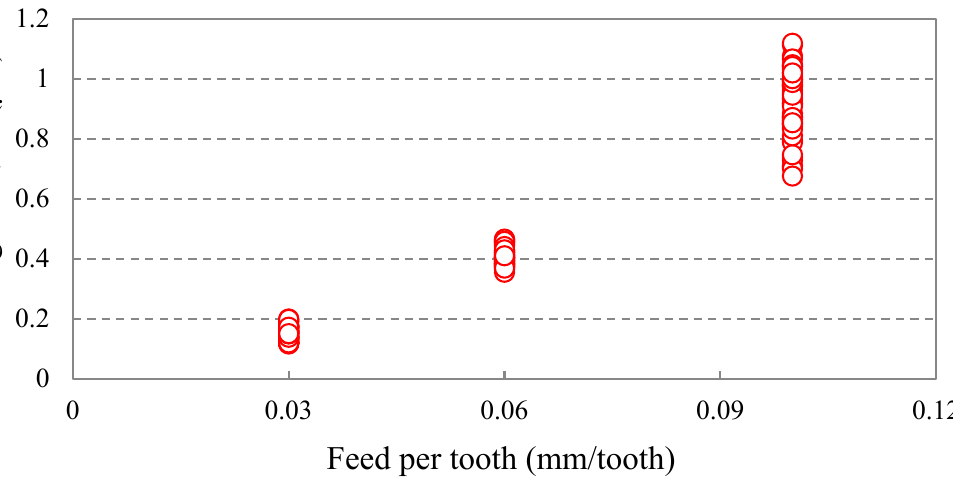
Figure 11. Roughness distribution graph in terms of feed per tooth.